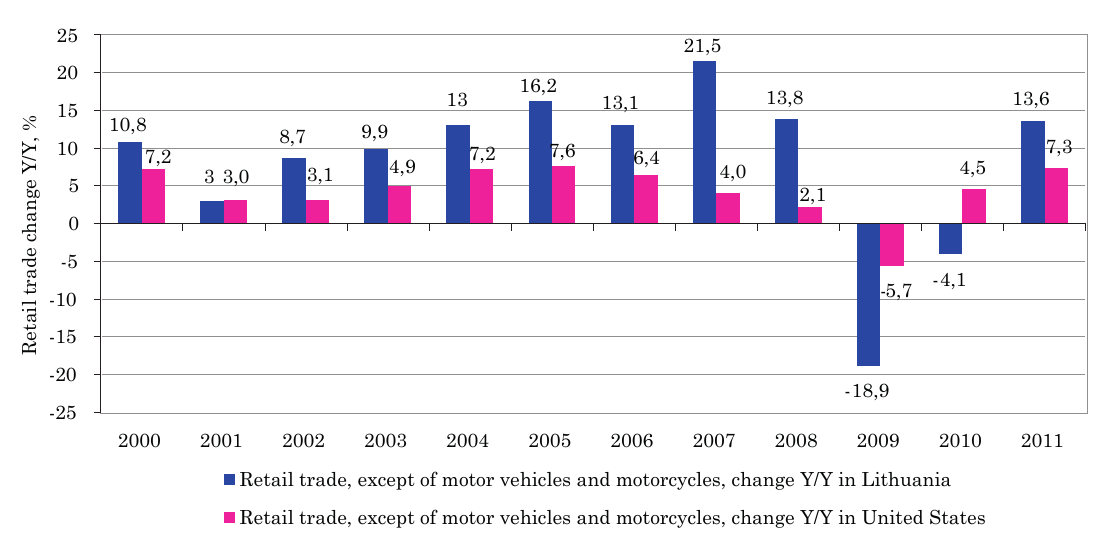
Figure 2. Retail trade dynamics in Lithuania and United States in 2000–2011 ( Wholesale ..., 2000–2011; Retail trade …,